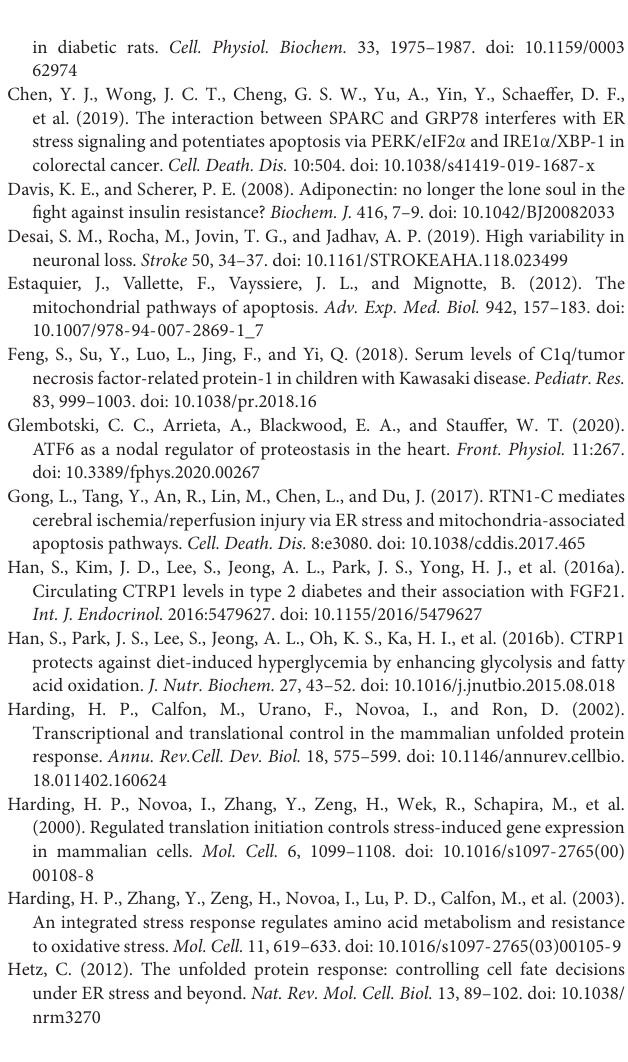
Supplementary Figure 1 | Experimental groups and protocol. (A) The groups in the studies. (B) Experimental protocol schedule. (C) Changes in cerebral blood flow were monitored during MCAO by laser Doppler flowmeter. Supplementary Figure 2 | The identification of neurons and the expression of CTRP1 in primary cortical neurons ( n = 3). The representative images